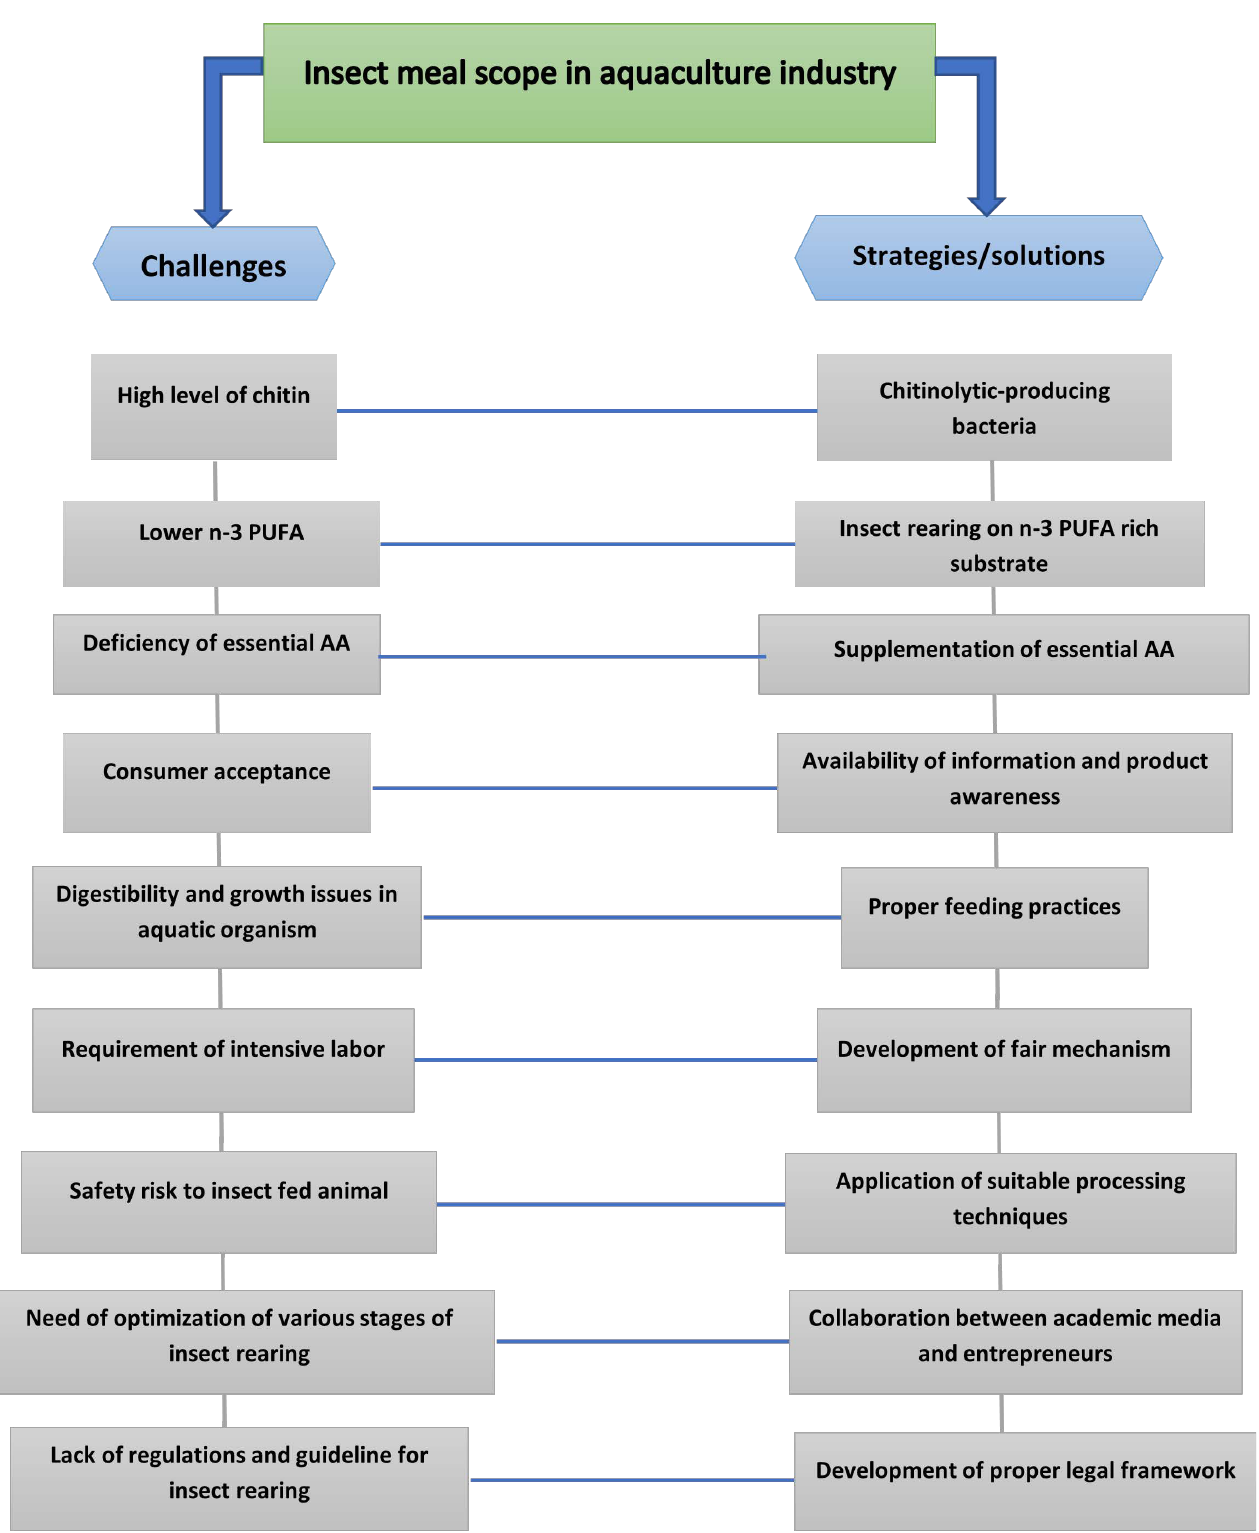
Figure 3. Challenges and solutions of insect-based meal in aquaculture